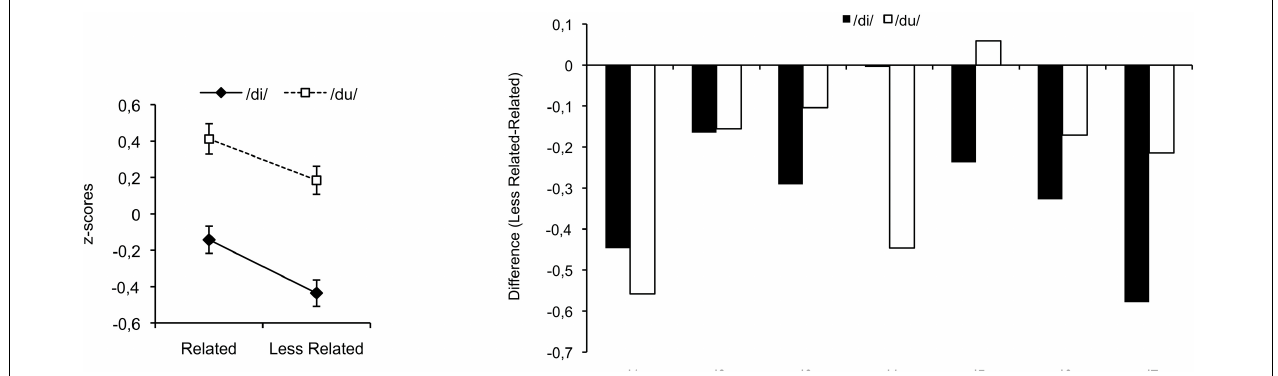
FIGURE 4 | Average data of the CI participants on the left and their individual data on the right. Positive and negative values indicate facilitated processing for related and less-related targets,